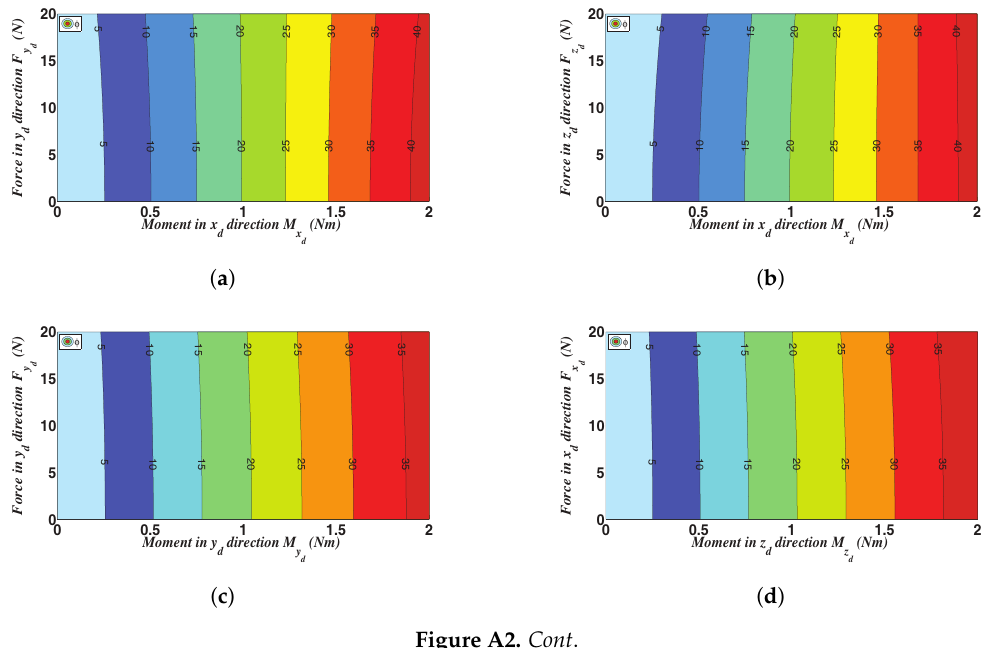
Figure A1. Contour plots of δ ∗ for all the loading cases: ( a ) moment, M x M x , and force, F z ; ( c ) moment, M y d d and force, F y ; ( f ) moment, M z d